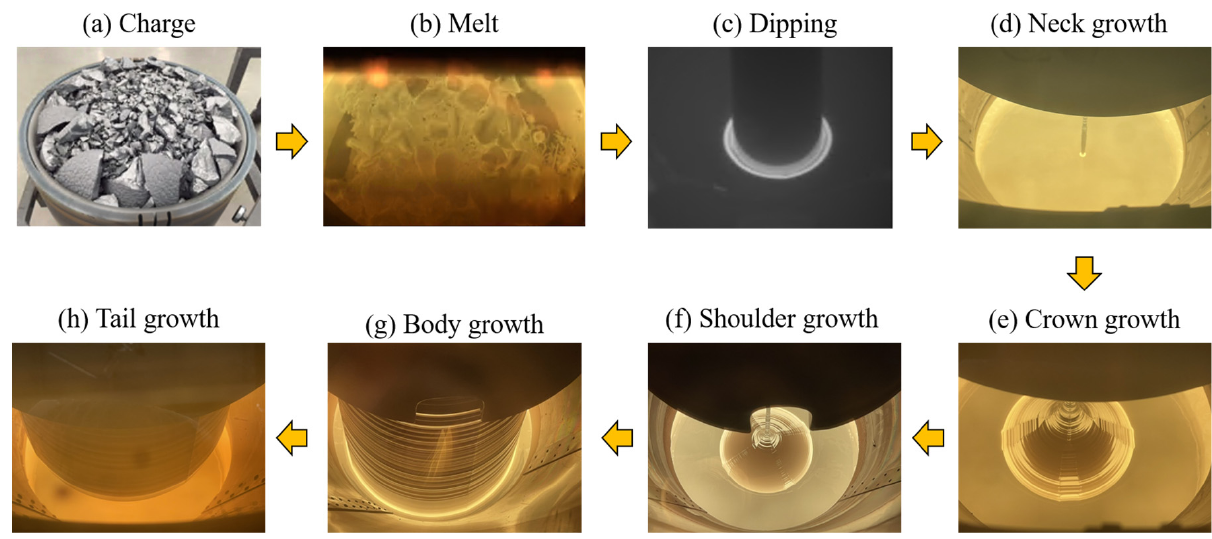
Figure 1. The different steps of CZ single-crystal Si growth. ( a ) Charge, ( b ) Melt, ( c ) Dipping, ( d ) Neck growth, ( e ) Crown growth, ( f ) Shoulder growth, ( g ) Body growth, and ( h ) Tail growth. The samples were acquired from the ingot head, as shown in Figure 2. The thickness was 2.5 ± 0.5 mm, perpendicular to the [100] crystal orientation, and sliced into